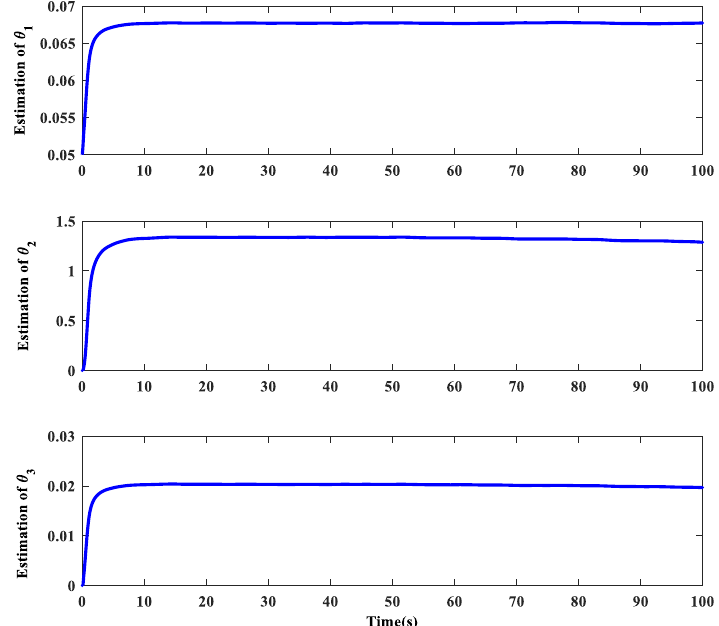
Figure 11. The parameter estimations of θ 1 ~ θ 3 with the ADRAC.